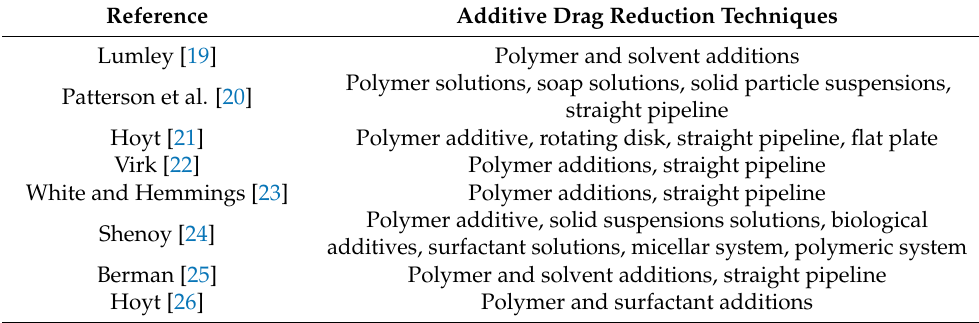
Table 1. Different review papers covering drag reducing